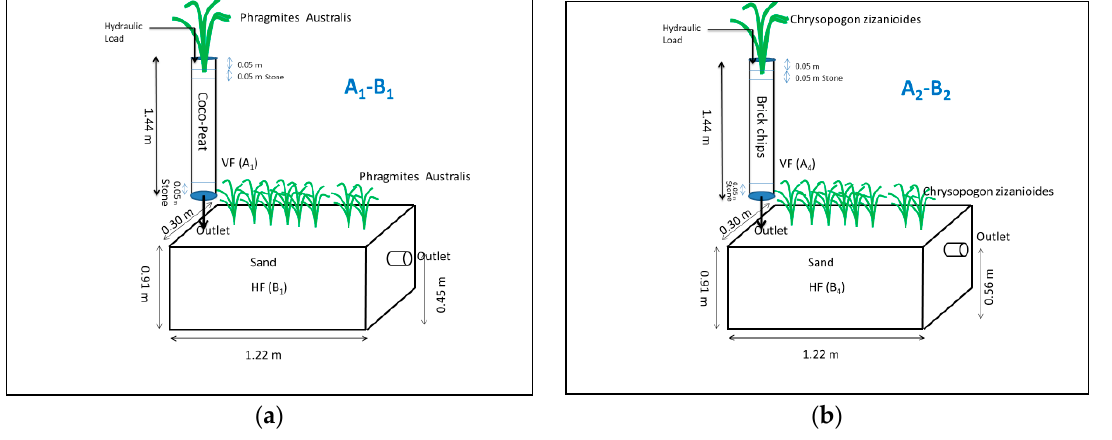
Figure 1. ( a , b ) . Engineered drawing of experimental set-up: ( a ) A 1 -B 1; ( b ) A 2 -B 2, for heavy metal